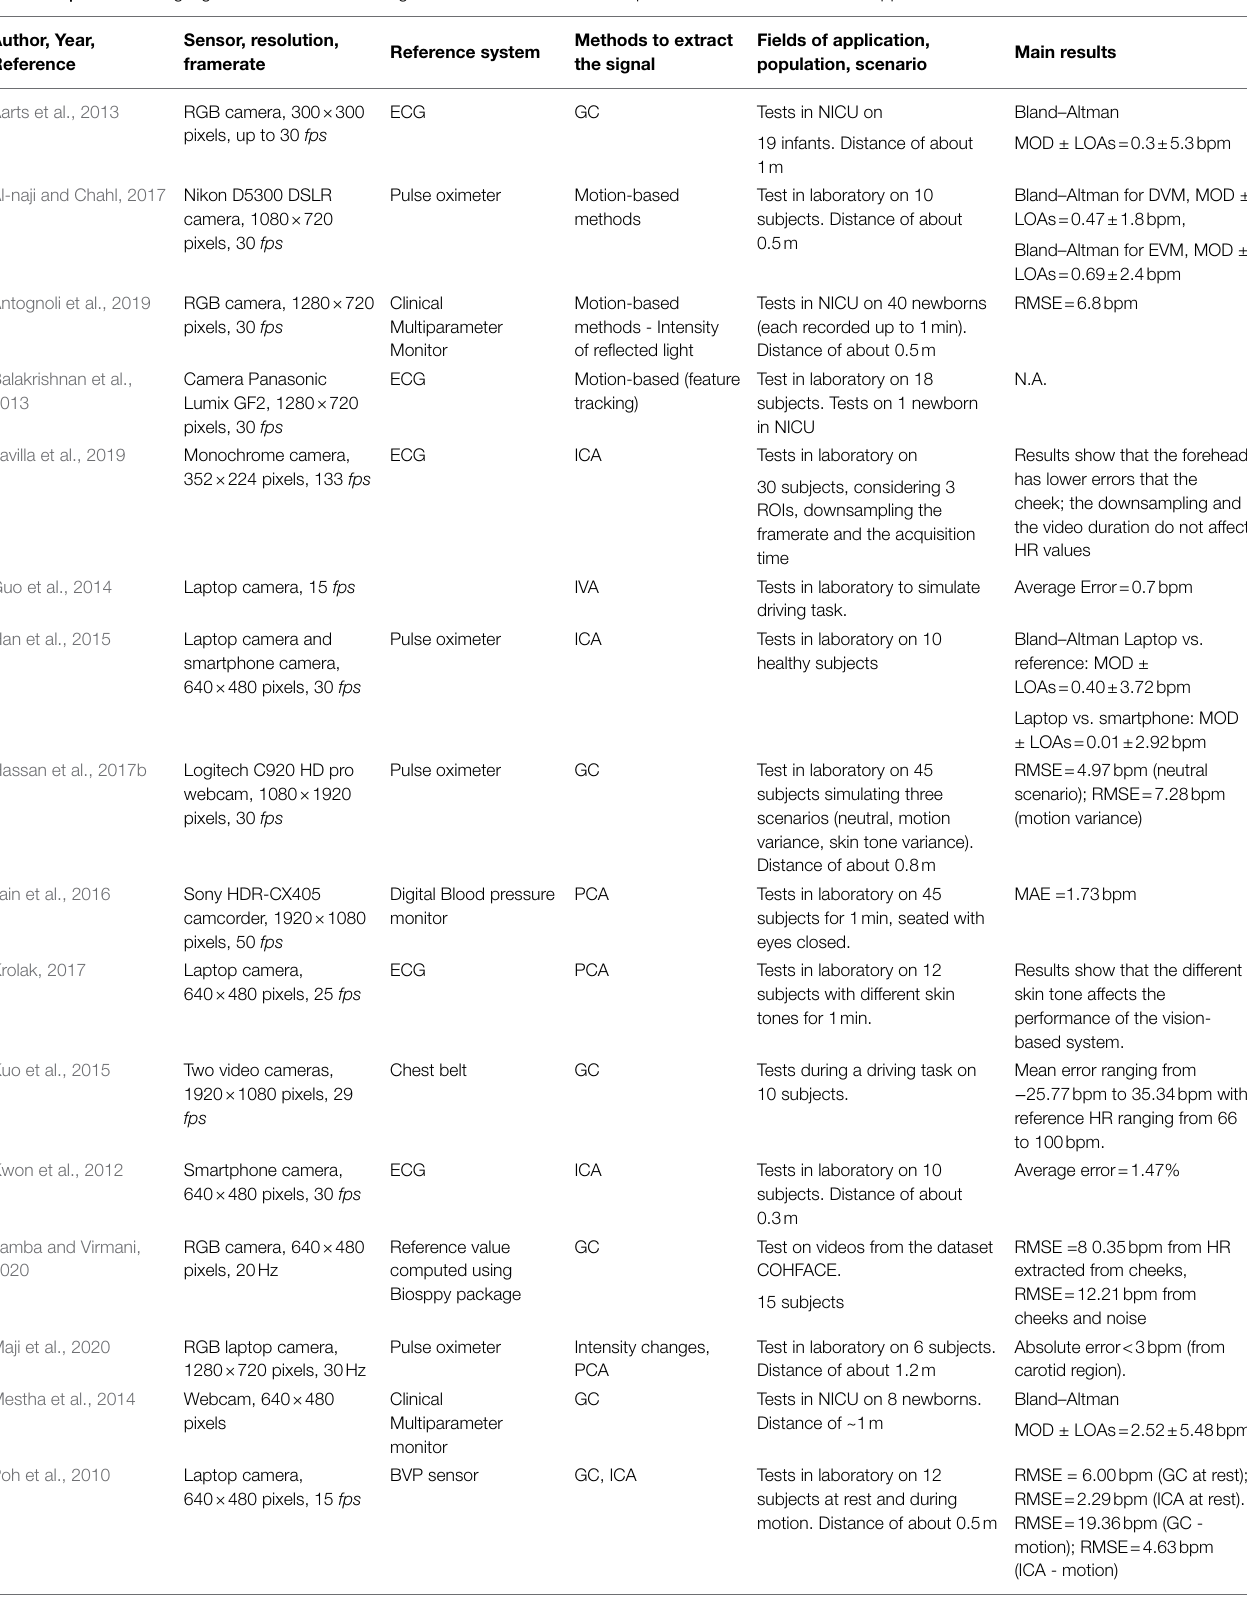
TABLE 2 | Studies using digital cameras for estimating HR and other cardiac-related parameters in different fields of